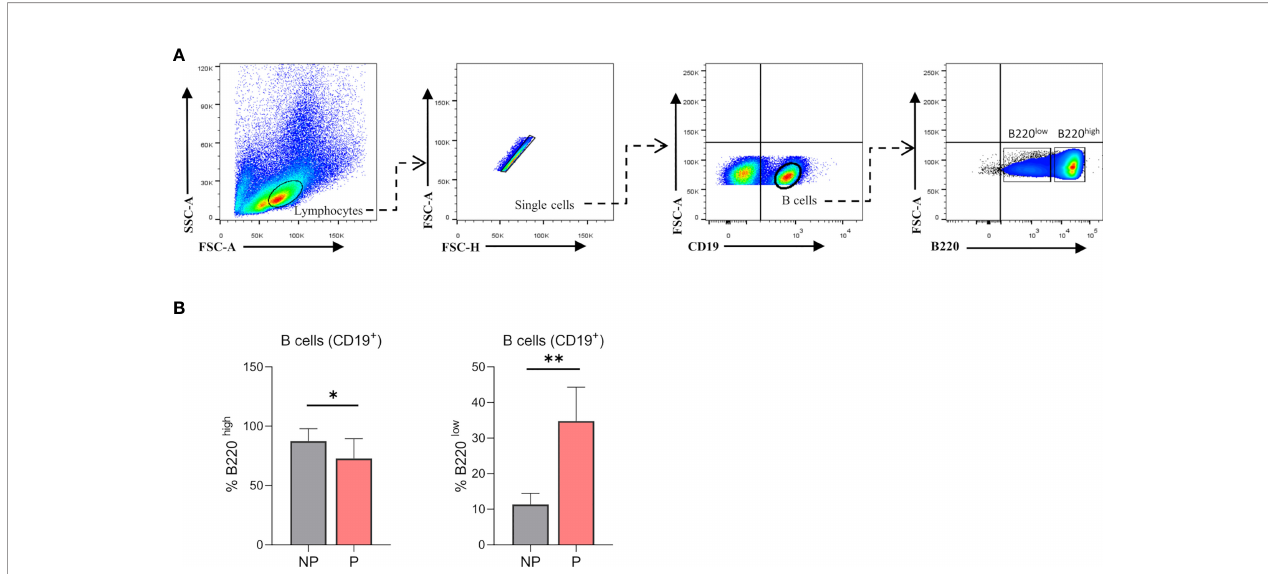
FIGURE 3 | (A) . Gating strategy. Representative contour plots showing gating strategy used to quantify percentages of B1 and B2 B cells in the spleen of pregnant (P) and non-pregnant (NP) mice. Lymphocytes were gated by FSC vs. SCC, doublets were eliminated and CD19 was used to de fi ne the total B cell population in the spleen. In the B cell (CD19 + ) gate, B220 was used to determine B1 (CD19 + B220 low ) and B2 (CD19 + B220 high ) B cell populations. Auto- fl uorescence of each biological replicate was used as a negative control for CD19 and B220. (B) . Comparison of percentages of splenic B1 and B2 B cells in pregnant and non-pregnant mice. Splenic B1 B cells (CD19 + B220 low ) were signi fi cantly increased in P (34.8±4.3; n=5) as compared to NP (11.35±1.6; n=4) mice. Splenic B2 B cells (CD19 + B220 high ) were signi fi cantly diminished in P (72.8±6.4; n=7) as compared to NP (87.5±3.9; n=7) mice. Unpaired Student ’ s t-test ( a =0.05), (*) p<0.05, (**)